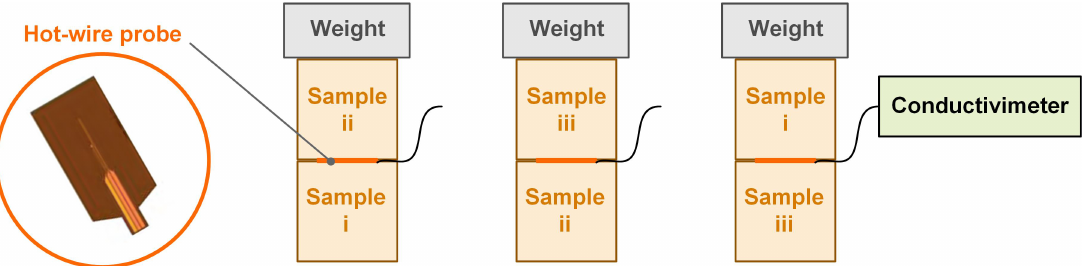
Figure 5. Measurement of thermal conductivity: Schematics of hot wire probe ( left ) and specimen coupling ( right